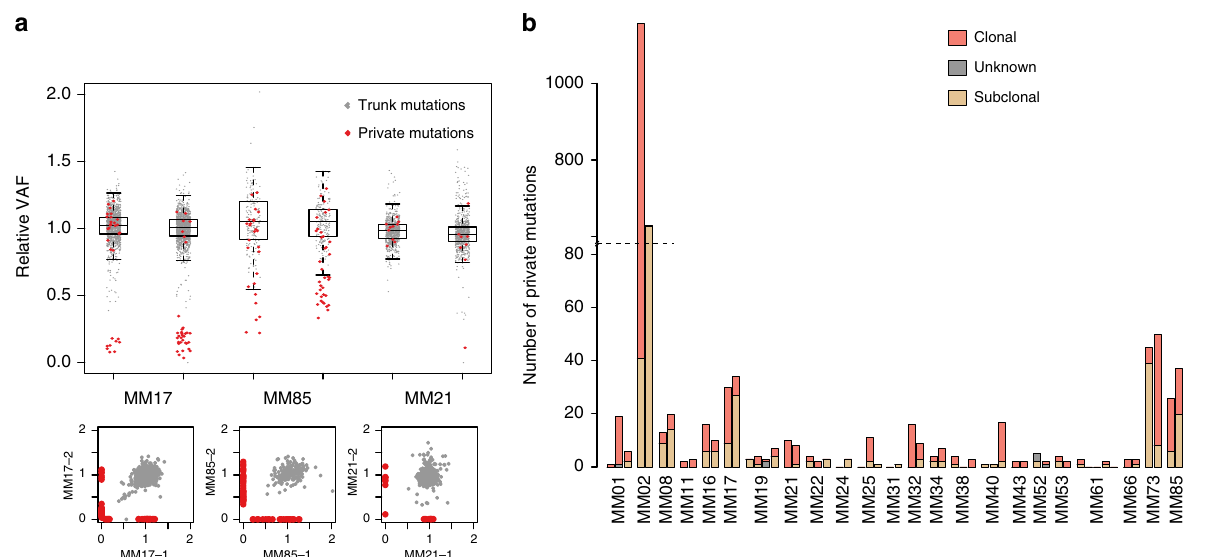
Fig. 4 Cellular prevalence of mutations. a Relative variant allele frequency (rVAF); that is observed variant allele frequency corrected by tumor purity, local total copy number and estimated number of mutated alleles, for mutations in six representative samples from three patients. In theory, relative VAF is equivalent to cellular prevalence of the mutations. Mutations are colored according to presence in other lesions; gray, trunk mutations; red, private mutations. Boxes with whiskers are based solely on the trunk mutation relative VAFs and span the interquartile range (IQR), with whiskers extending to 1.5 times the IQR of the trunk relative VAF from the upper and lower bounds of the boxes. The three lower panels show examples of pairwise comparisons. b Private mutations were classi fi ed according to status as clonal or subclonal, where subclonal mutations are those whose relative VAF is below the whiskers in a . Mutations below half the median relative VAF and above the subclonality threshold are de fi ned as